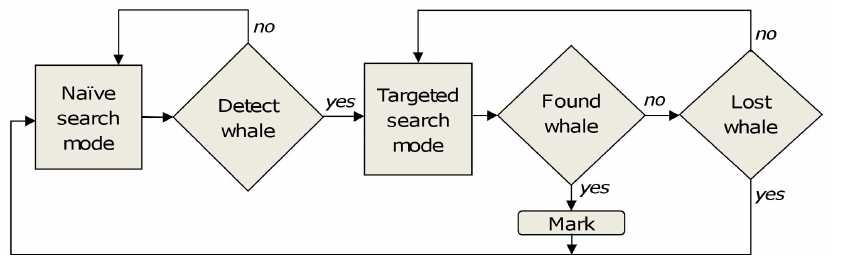
Figure 2. Schematic of simulated vessel tracking modes. The vessel begins in naı¨ve search mode. Upon detecting a group, the vessel switches to targeted mode and, if the whale is found, it proceeds to mark the group; if it is lost it returns to naı¨ve search.